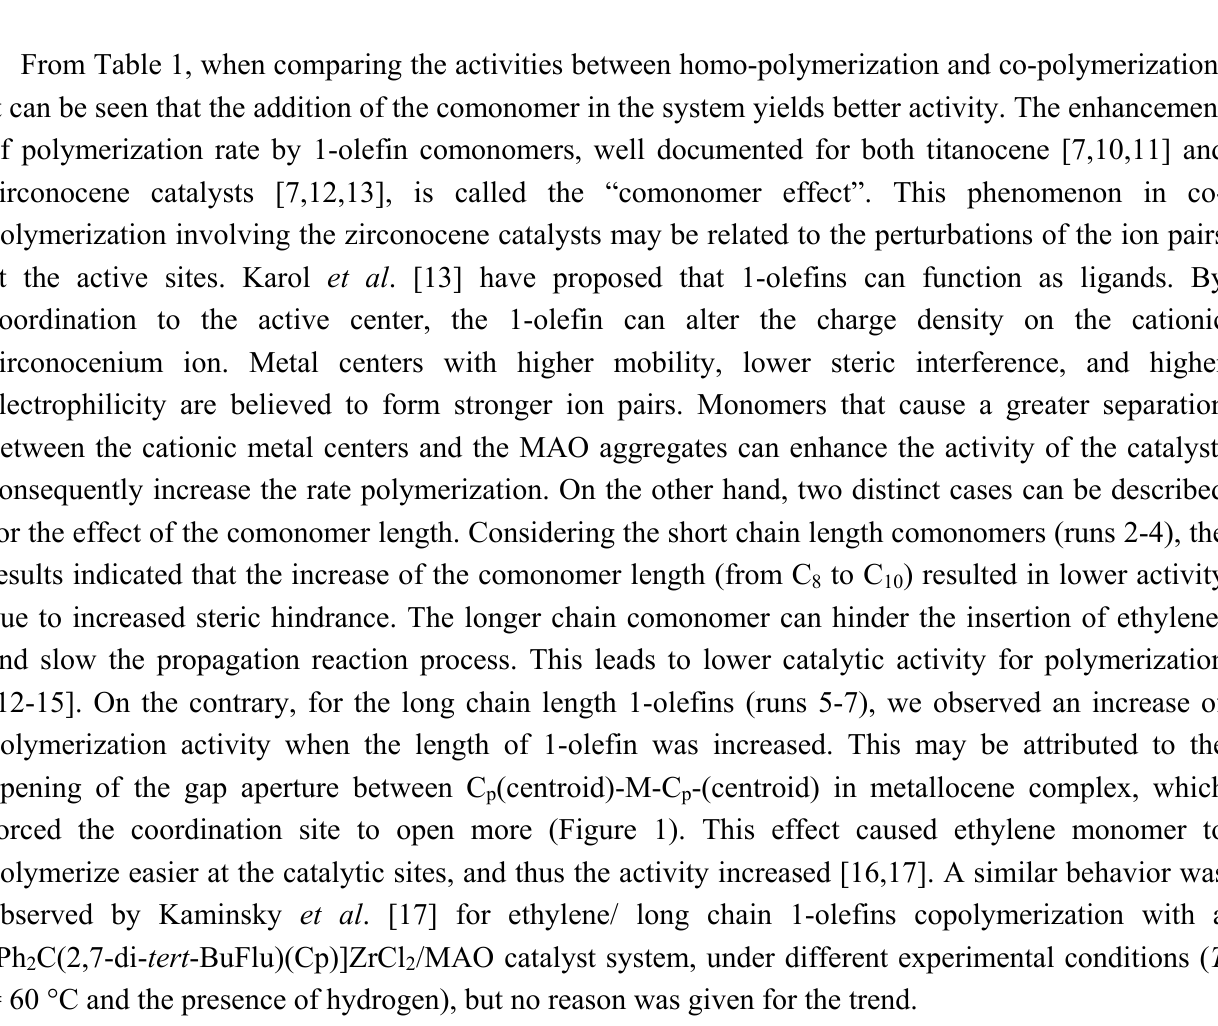
Table 1. Copolymerization of ethylene with long chain 1-olefins using rac - Et[Ind] ZrCl /MAO, as the catalytic system. 2 2 Polymerization Polymer Catalytic activity b Run number Olefin type time (s) yield a (g) (×10 -4 kgPol/molZr h) 1 - 115 0.8703 1.8 2 1-C 124 1.4781 2.9 6 3 1-C 97 1.5529 3.8 8 4 1-C 115 1.6783 3.5 10 5 1-C 109 1.6134 3.6 12 6 1-C 89 1.3704 3.7 14 7 1-C 123 2.3157 18